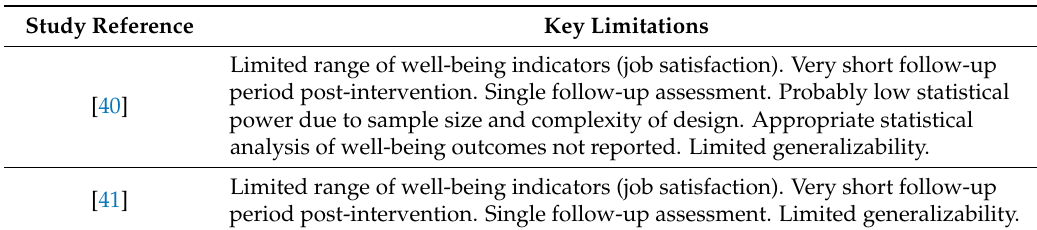
Table 4. Key limitations of studies on fairness